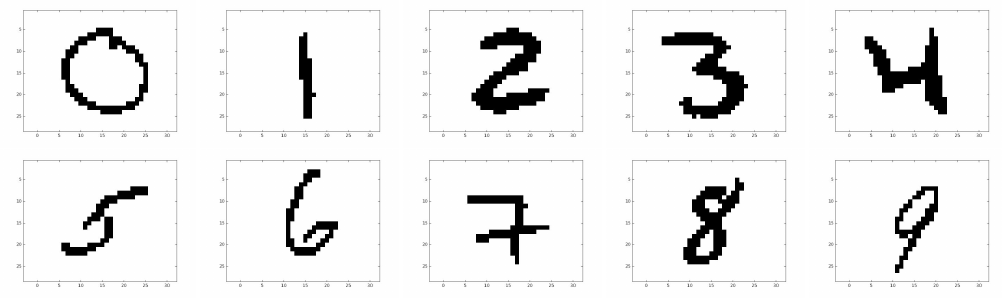
Figure 1: A sample from the binary handwritten digit data. Each pixel of a 16 × 16 image is either 0 (depicted in white) or 1 (depicted in